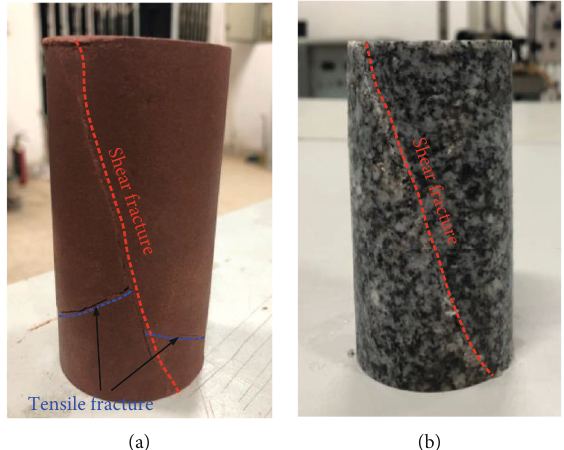
Figure 3: Fractured (a) sandstone and (b) granite specimens.